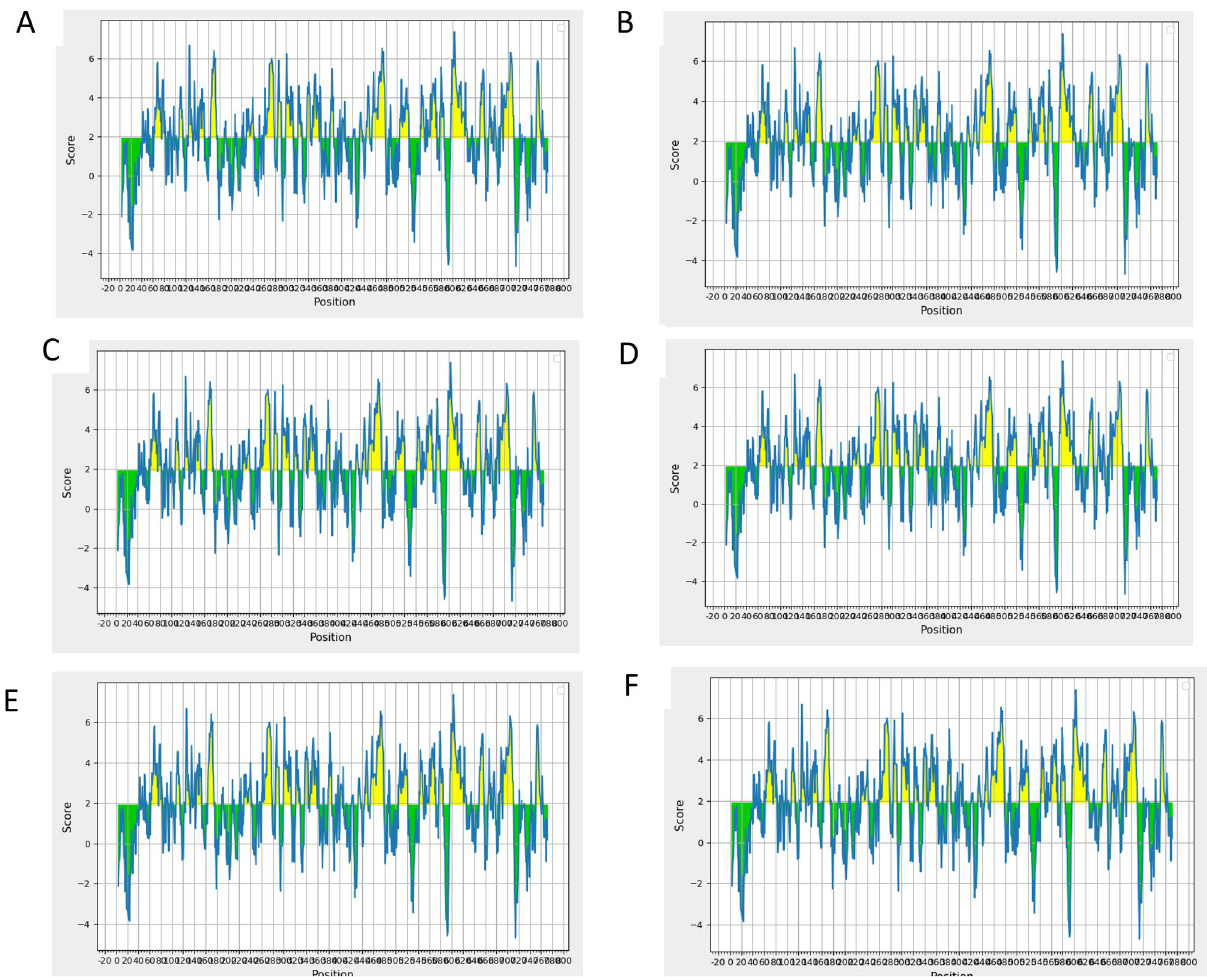
Figure 4. B-cell epitopes Analysis. ( A ) Bepipred Linear Epitope, ( B )Chou &amp; Fasman Beta-Turn Prediction, ( C ) Emini Surface Accessibility Prediction, ( D ) Karplus&amp; Schulz Flexibility Prediction, ( E ) Kolaskar &amp; Tongaonkar Antigenicity, ( F ) Parker Hydrophilicity